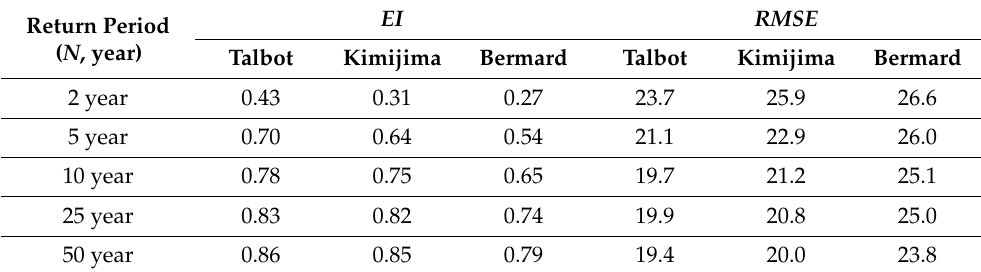
Table 2. EI and RMSE for Talbot, Kimijima and Bermard.